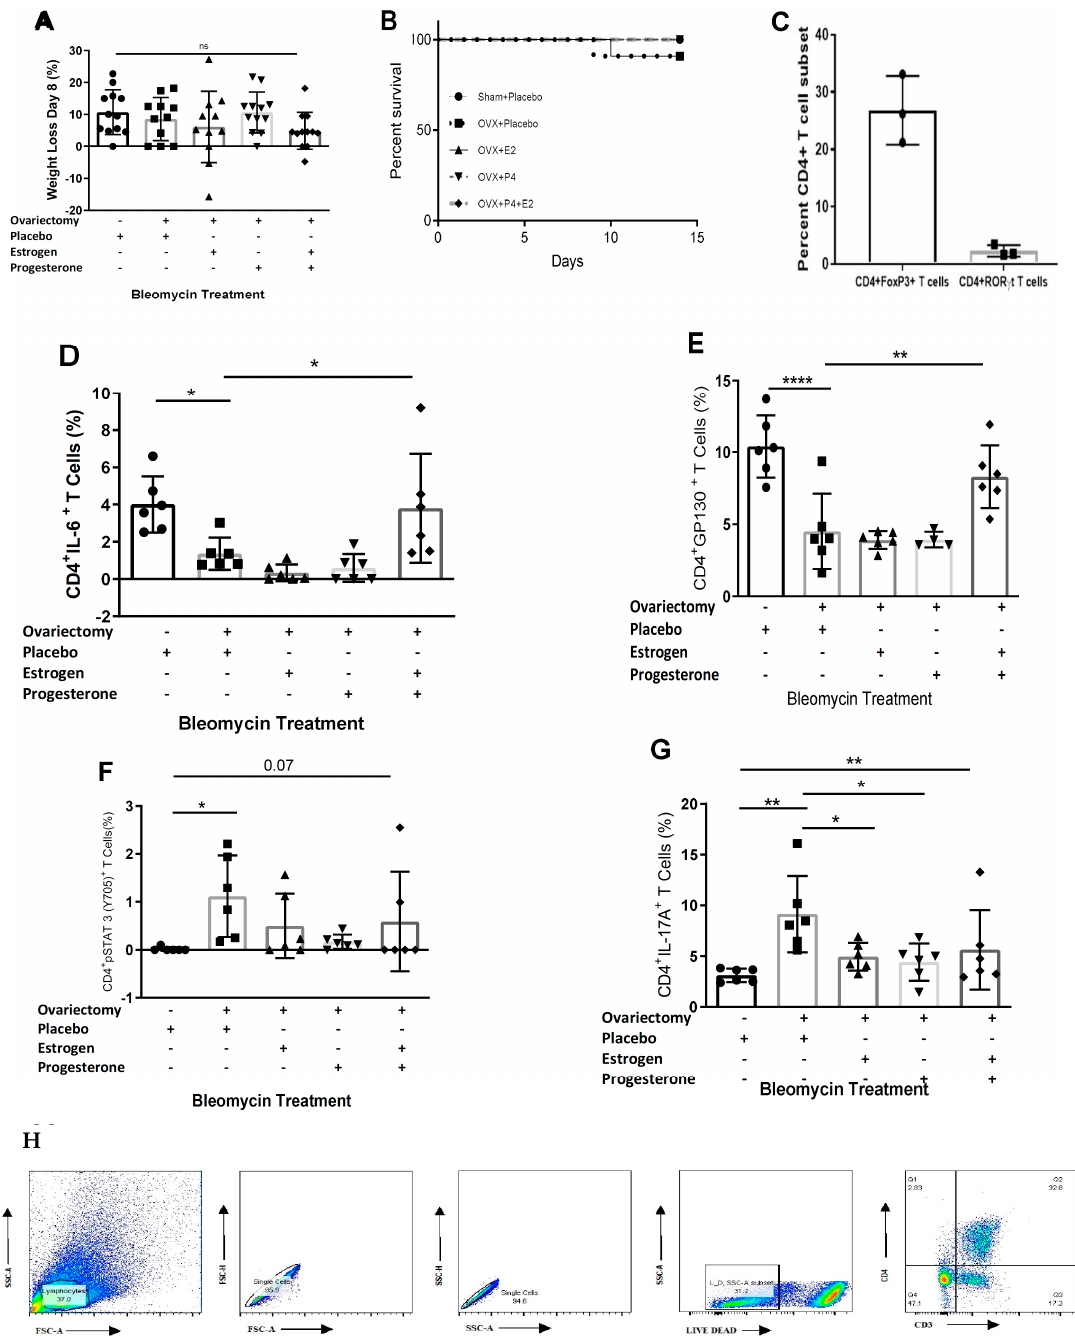
Figure 3. In vivo administration of female hormones increases profibrotic cytokine expression in ovariectomized mice . Hormone-containing or placebo pellets were implanted into ovariectomized C57BL/6 female mice for 21 days, followed by bleomycin administration and monitoring for an additional 14 days. ( A ) Body weights of mice at day 8 after bleomycin administration; ( B ) Murine mortality across 14 days; ( C ) Flow cytometric analysis of T cells from single-cell lung suspensions for ( D ) IL-6, ( E ) GP130, ( F ) pSTAT3Y705 and ( G ) IL-17A. ( H ) Representative FACS plots illustrating CD4+ percentage in bleomycin-treated murine cohorts. Comparisons between cohorts were performed using one-way ANOVA with Tukey’s post hoc test. * p < 0.05, ** p < 0.01, **** p < 0.0001. ns: no significance; RLL: right lower lobe. Bars are the mean ± SD; each dot represents an individual mouse. N = 3–12 per